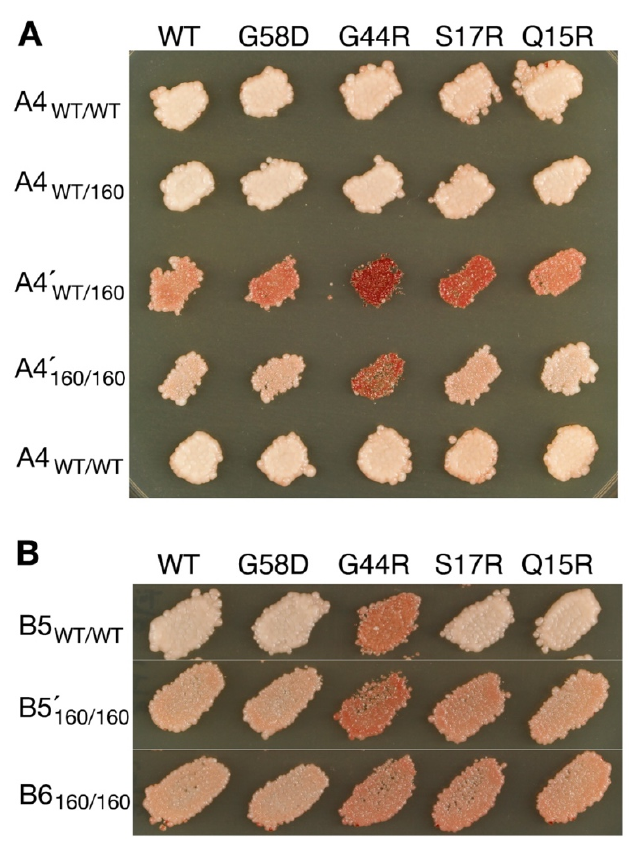
Figure 2. Transmutable [ PSI + ] variants revealed in cells expressing Hsp104 T160M . ( A ) The A4 variant becomes A4 ′ in cells expressing Hsp104 T160M as indicated by distinct patterns of colony color in variant typing. In support of their separate identities, A4 and A4 ′ are shown to remain distinguished in the same Hsp104 WT/T160M background (WT/160). Variant typing is as described in Figure 1. WT/WT and 160/160 indicate Hsp104 WT/WT and Hsp104 T160M/T160M homozygotes, respectively. ( B ) B5 becomes B5 ′ . The latter is likely a mixture of B5 and B6, as revealed by back-transfer to a WT background (see Table 3).